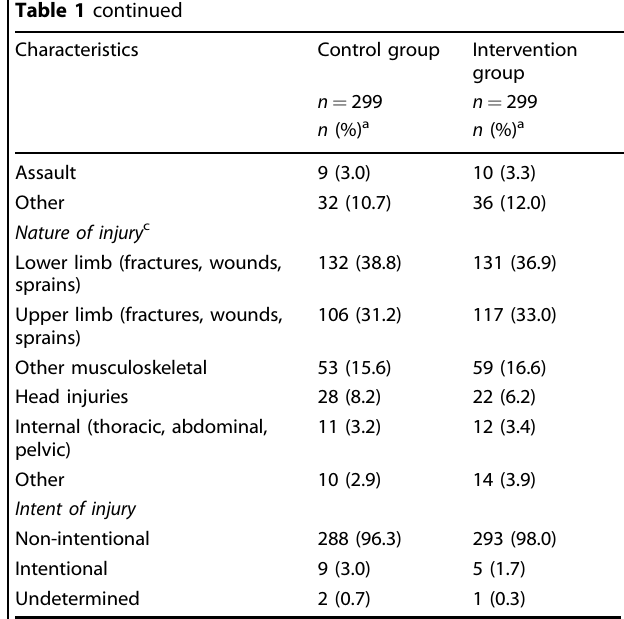
Baseline and drinking characteristics